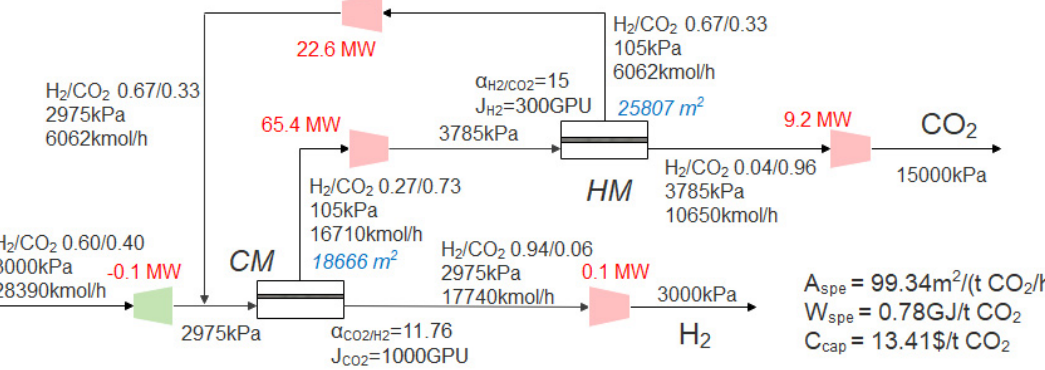
Figure 7. The optimal process when using the commercial membrane in Table 2 and optimizing the pressure. the